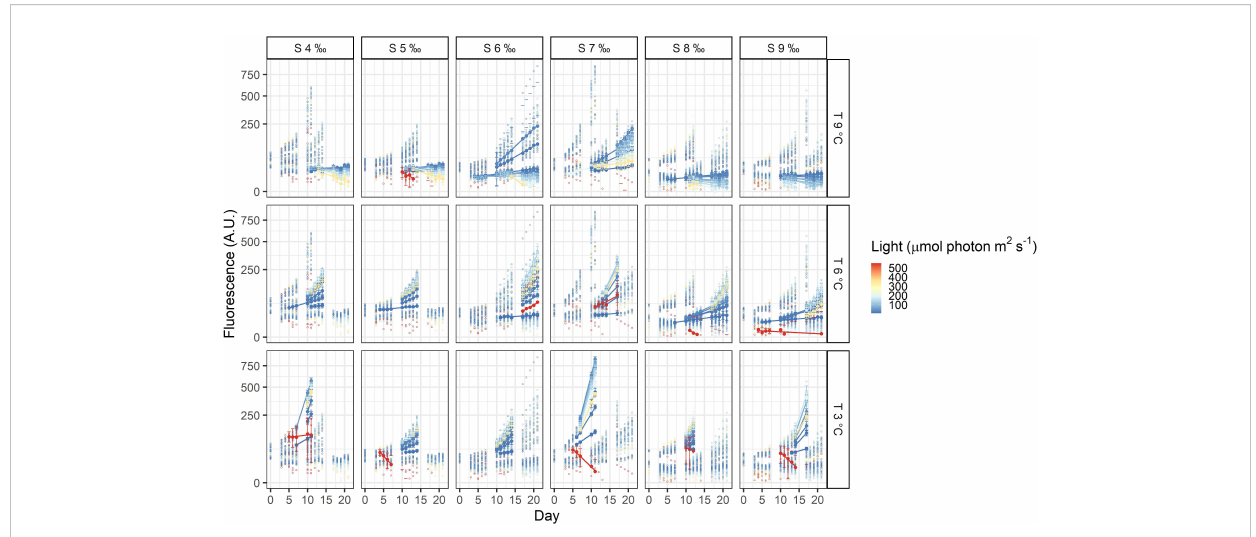
FIGURE 5 Fluorescence time series of Heterocapsa arctica subsp. frigida . Each circle is the observed fl uorescence of each well in each day. Daily means and standard deviations of the observations used to calculate the growth rates are depicted as full points with the error bars. The lines are linear regressions, included only for visualization purposes.